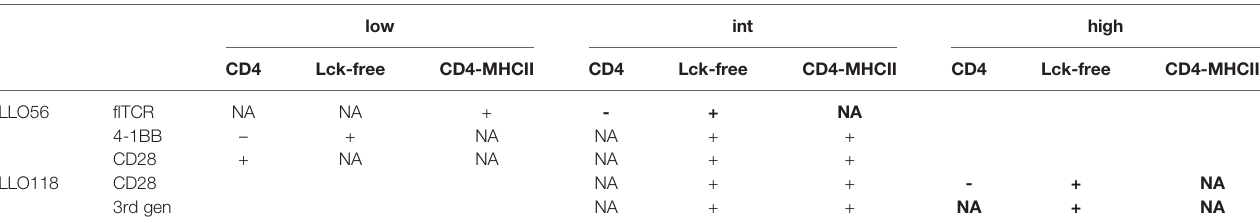
TABLE 3 | Summary of Figures 6